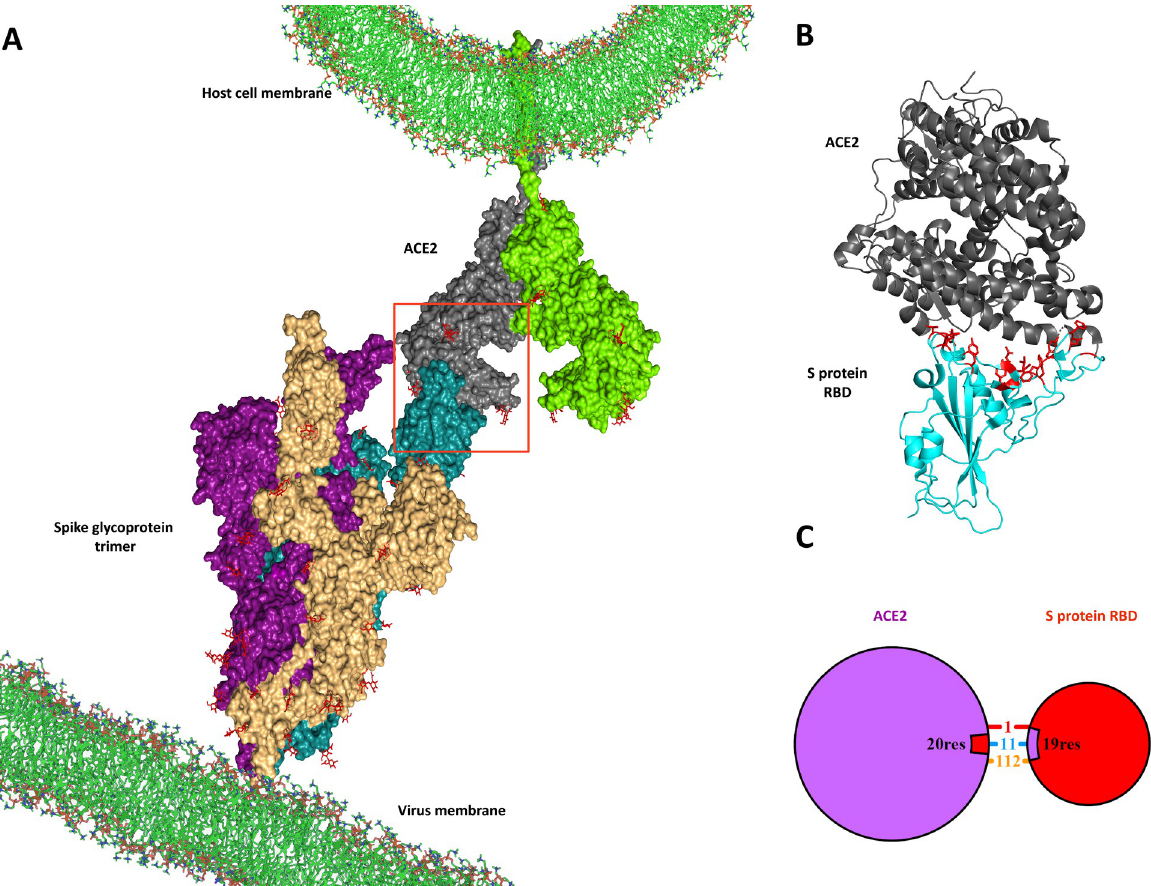
Fig 1. a. Attachment of SARS-CoV-2 to host cell b. The crystal structure of the RBD-ACE2 complex, RBD residues that interact with ACE2, are shown as red sticks (PDB ID: 6lzg). c. RBD-ACE2 Interactions (salt bridge: red, Hydrogen bond: blue, non-bonded contact: orange).